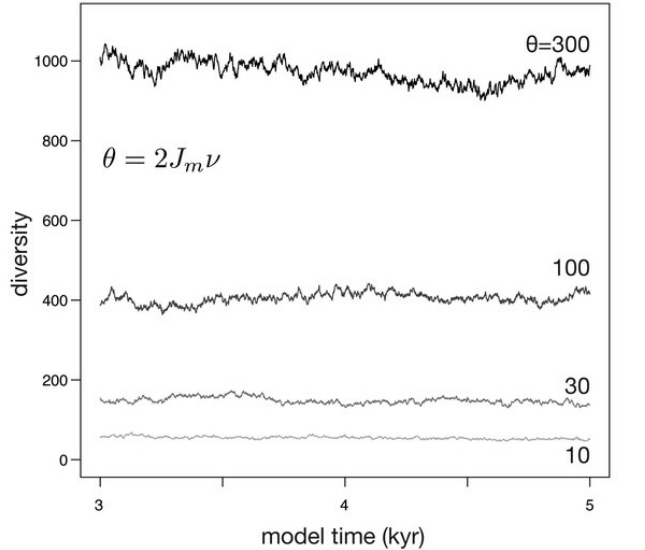
Figure 4. Simulations depicting the effect of θ on diversity when habitat area